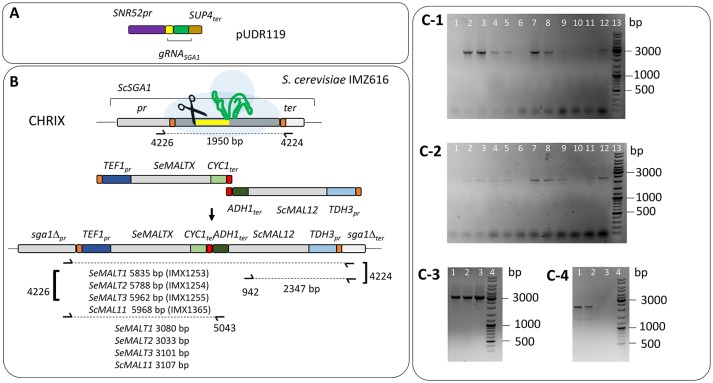
Integration of S. eubayanus CBS 12357T maltose transporter genes at the ScSGA1 locus of S. cerevisiae IMZ616 (mal1Δ mal2Δ mal3Δ mph2Δ mph3Δ::suc2Δ ima1Δ ima2Δ ima3Δ ima4Δ ima5Δ Spcas9) (Marques et al., 2018). (A) Integration at the ScSGA1 locus by Cas9-assisted genome editing. The Cas9-targeting gRNA was expressed from pUDR119 (van Rossum et al., 2016). (B) Schematic representation of the integration of SeMALT expression cassettes at the ScSGA1 locus. Upon cleavage, the Cas9-induced double strand break was repaired by the two co-transformed fragments harboring a transporter gene expression cassette and the S. cerevisiae maltase gene MAL12, respectively. Primers used for verification of transformants from transformation are indicated together with the size of the expected PCR products. Integration of SeMALT1, SeMALT2, SeMALT3 or ScMAL11 resulted in S. cerevisiae strains IMX1253, IMX1254, IMX1255, and IMX1365 respectively. (C) Validation of the S. cerevisiae IMX1253, IMX1254, IMX1255, and IMX1365. (C-1) Lane 13 GeneRuler DNA Ladder Mix (Thermo Fischer Scientific). Lanes 1 to 12 fragments amplified with primers 4226 and 5043. Lanes 1, 2, 3, and 4 fragments amplified from clones transformed with SeMALT1. The strain corresponding to lane 3 was renamed IMX1253. Lanes 5, 6, 7, and 8 fragments amplified from clones transformed with SeMALT2. The strain corresponding to lane 7 was renamed IMX1254. Lanes 9, 10, 11, and 12 fragments amplified from clones transformed with SeMALT3. The strain corresponding to lane 12 was renamed IMX1255. (C-2) Lane 13 GeneRuler DNA Ladder Mix (Thermo Fischer Scientific). Lanes 1 to 12 fragments amplified with primers 942 and 4224. Lanes 1, 2, 3, and 4 fragments amplified from clones transformed with SeMALT1. Lane 3 corresponds to IMX1253. Lanes 5, 6, 7, and 8 fragments amplified from clones transformed with SeMALT2. Lane 7 corresponds to IMX1254. Lanes 9, 10, 11, and 12 fragments amplified from clones transformed with SeMALT3. Lane 12 corresponds to IMX1255. (C-3) Lanes 1 to 3 fragments amplified with primers 4226 and 5043. Lanes 1, 2, 3, and 4 fragments amplified from clones transformed with ScMAL11. The strain corresponding to lane 3 was renamed IMX1365. Lane 4 GeneRuler DNA Ladder Mix (Thermo Fischer Scientific). (C-4) Lanes 1 to 4 fragments amplified with primers 942 and 4224. Lanes 1, 2, and 3 fragments amplified from clones transformed with ScMAL11. Lane 3 corresponds to IMX1365. Lane 4 GeneRuler DNA Ladder Mix (Thermo Fischer Scientific).